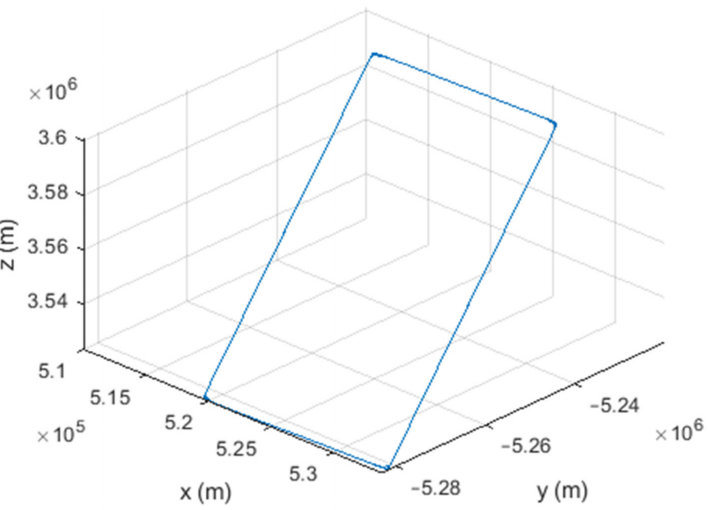
Figure 8. The fifth scenario: moving in a rectangular path at a speed of about 3200 m/s.